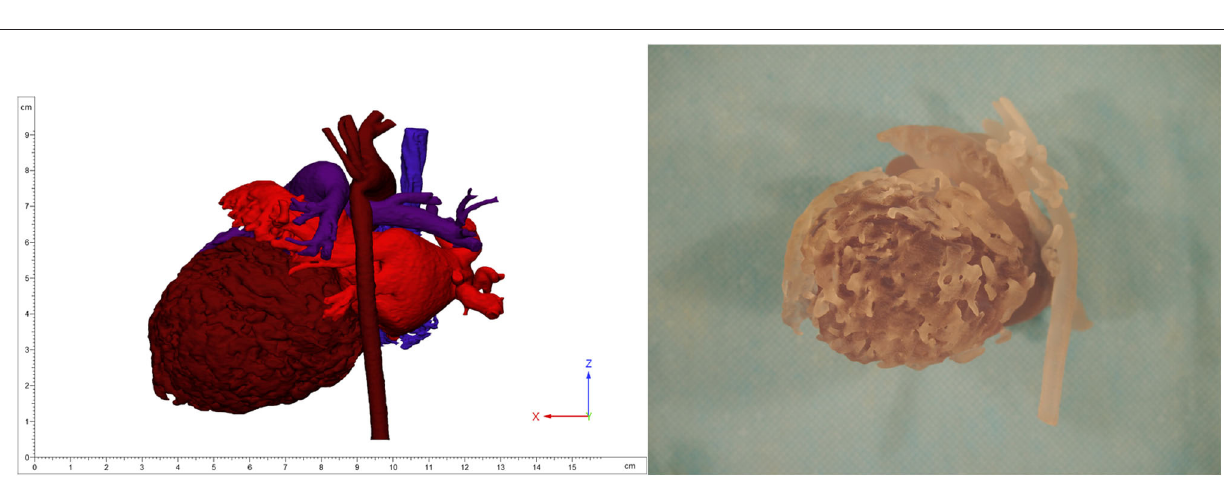
FIGURE 2 | 3D image (left) and printing (right) of non-compaction